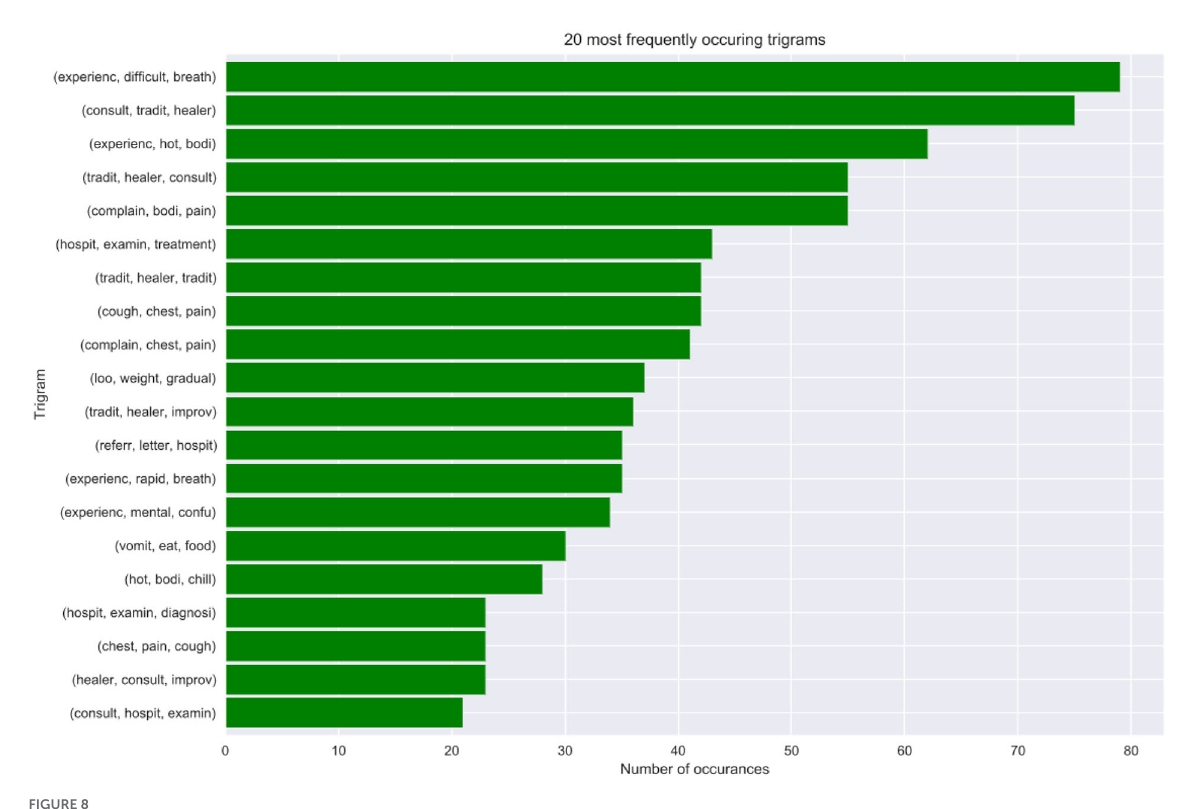
FIGURE8 Tri-gram model showing frequently occurring contradicting cases.